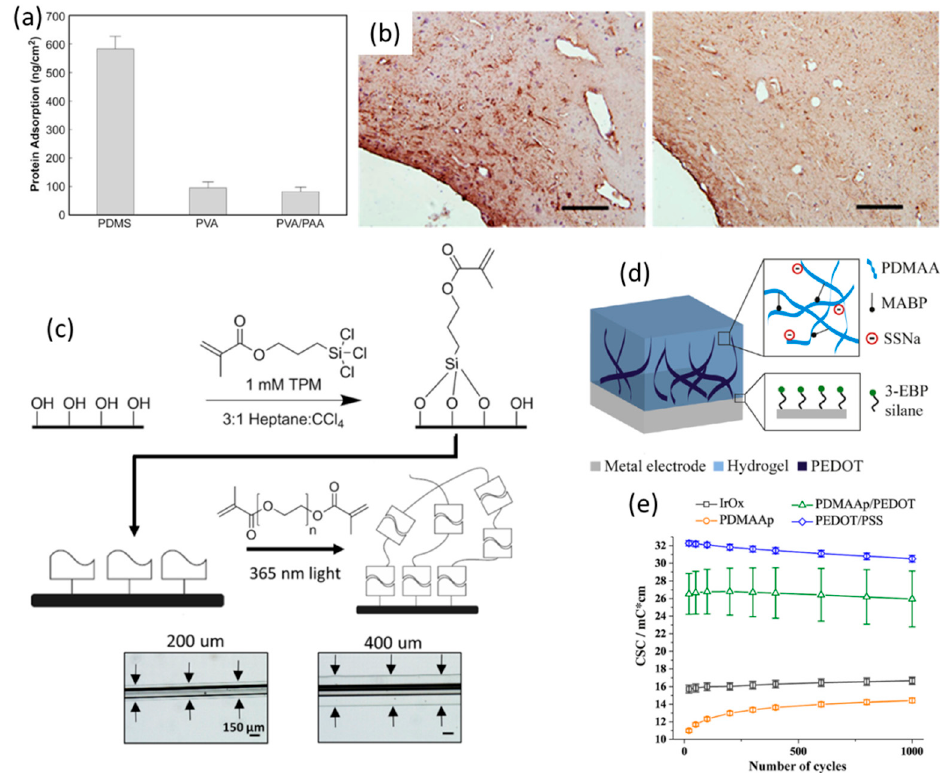
Figure 7. ( a ) Non-specific adsorption of protein (fibrinogen) on PDMS without a coating, with PVA coatings, and with PVA/PAA IPN (PAA/PVA = 10 mol%) film coatings ( n = 3). ( b ) GFAP immunostaining of uncoated (left) and PVA/PAA IPN (PAA/PVA = 10 mol%) film-coated (right) PDMS implants after six weeks post-implantation (bar = 50 mm). ( a , b ) are reproduced with permission from [213], Copyright 2009, Elsevier. ( c ) Soft PEG hydrogel coatings were formed on borosilicate glass capillaries through a multistep process. ( c ) is reproduced with permission from [48], Copyright 2017, Springer-Nature. ( d ) Schematic depiction of the CPH composition. The hydrogel component PDMAAp consists of the PDMAA backbone, the MABP crosslinker and the SSNa units, which serve as counterions during the deposition of PEDOT. The hydrogel is covalently attached to the surface with 3-EBP silane. ( e ) The mean CSC of the different coating materials is shown vs. repetitive cycling ( n = 1000 cycles) in PBS. ( d , e ) are reproduced with permission from [217], Copyright 2017, Elsevier.